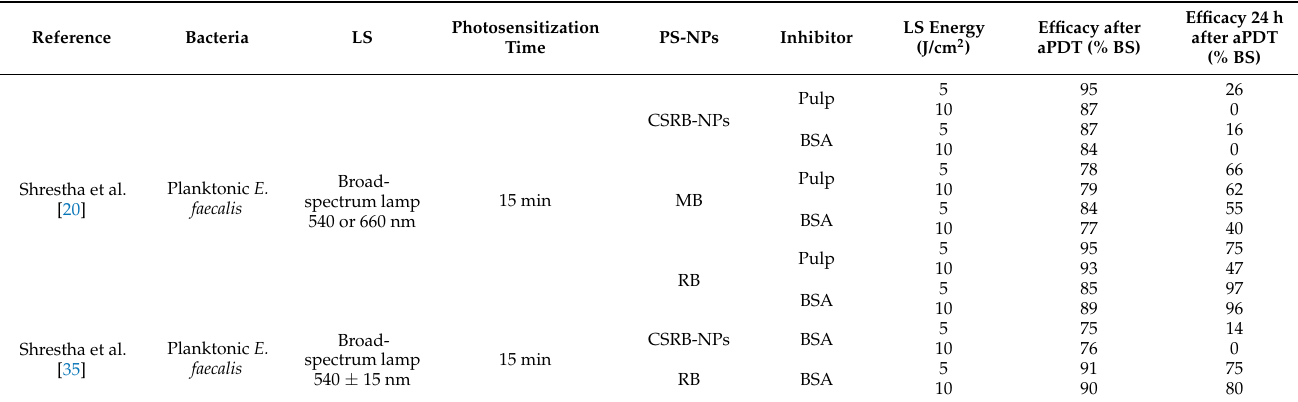
Table 3. Antibacterial substantivity and impact of inhibitors.